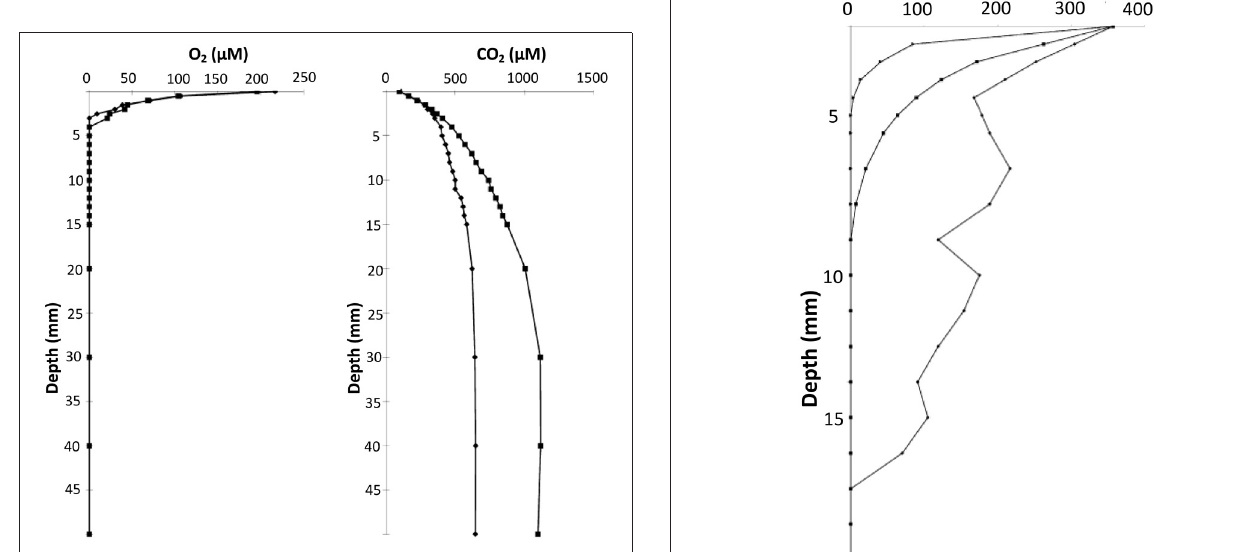
FIGURE 9 | O 2 concentration profiles under the rind of Cheddar cheese at 2 days ( (cid:7) ), 9 days ( (cid:4) ), and 15 days ( N ) of maturation. Adapted from Tammam et al.